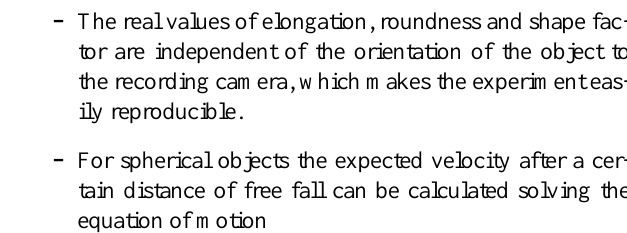
g. The vertical fall velocity v(D) (m s − 1 ) is the exact plane distance at the ( x , y ) location of the hydrometeor in the sensitive area divided by the time interval from the first hit in camera A to the first hit in camera